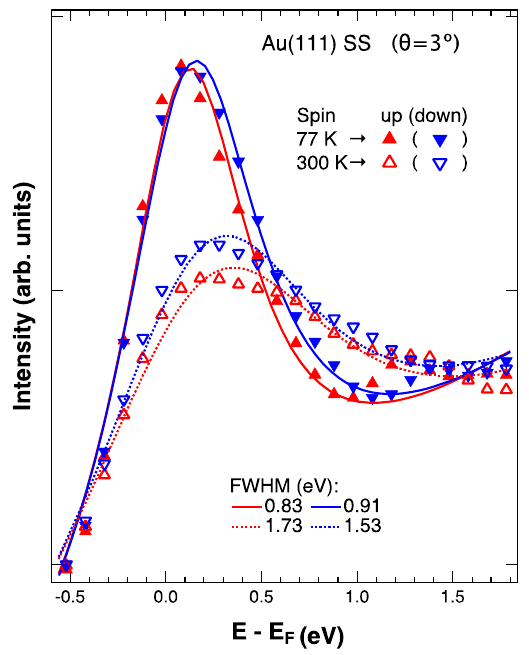
Fig. 1. SPIPES spectra of Shockley surface state of Au(111) at q = 3° as a function of the temperature of the GaAs photocathode. In the LT, the binding energy of the state is more defined as follows from the FWHM